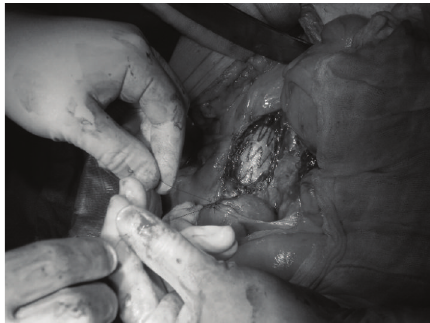
Figure 4: Closure of duodenal perforation.